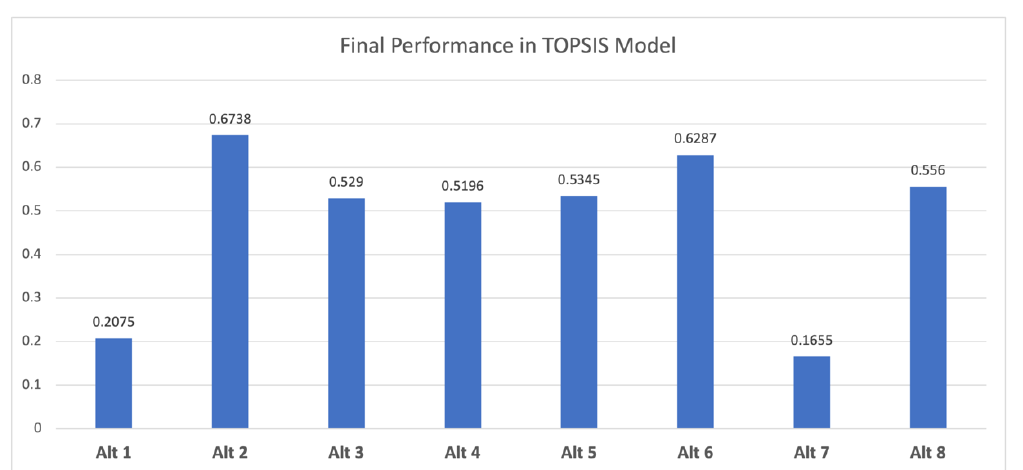
in the TOPSIS model is 𝑥